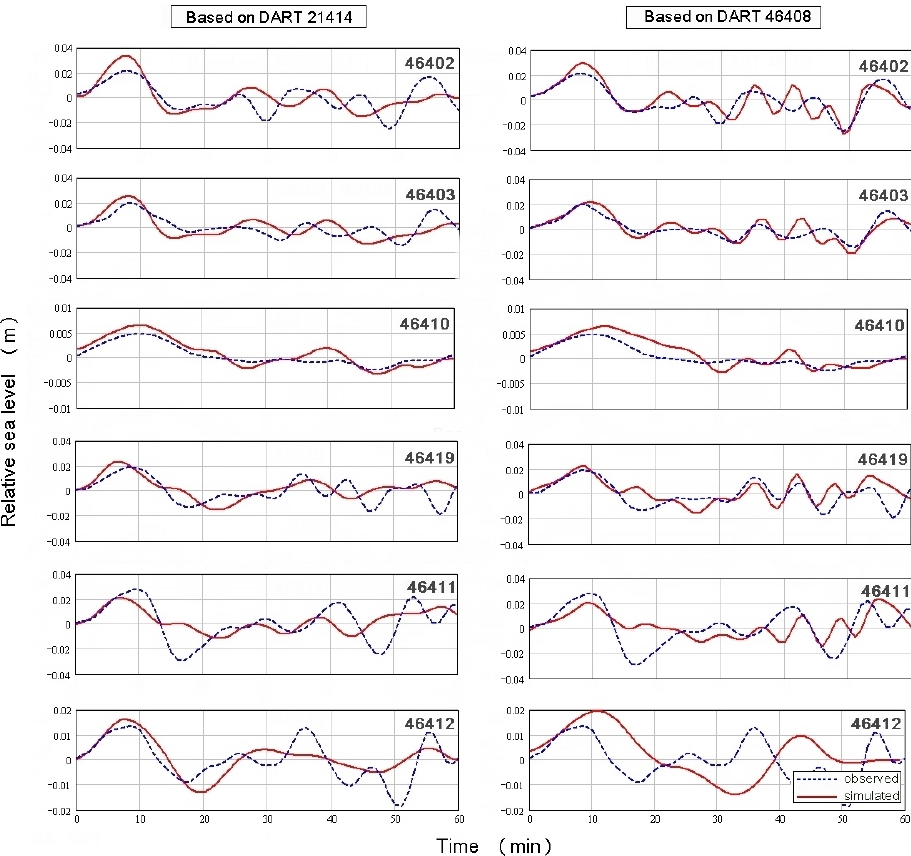
Fig. 5. Computed and observed tsunami waveforms for the 2006 Simushir earthquake for DART sites in the North Pacific Ocean (see Fig. 4 for the DART positions). Left column: using DART 21414 as the reference station; right column: using DART 46408 as the reference